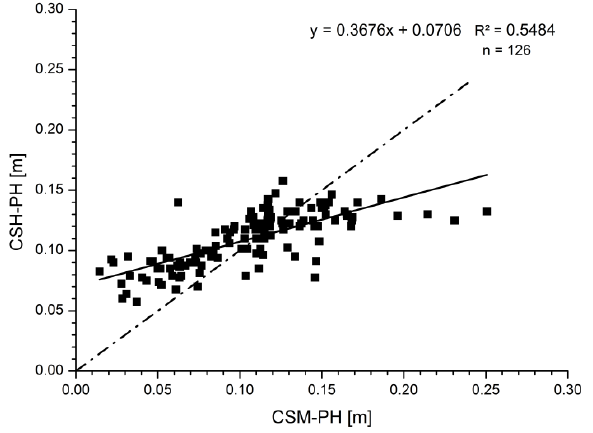
Figure 5. Plant height from Crop Surface Model (CSM-PH) versus plant height from compressed sward height (CSH-PH), G 2 & 3 The correlation is specified with a R² of 0.55 with a number of 126. In comparison to 1:1 line, regression line has a lower slope and the matching point is located in region of approx. 12